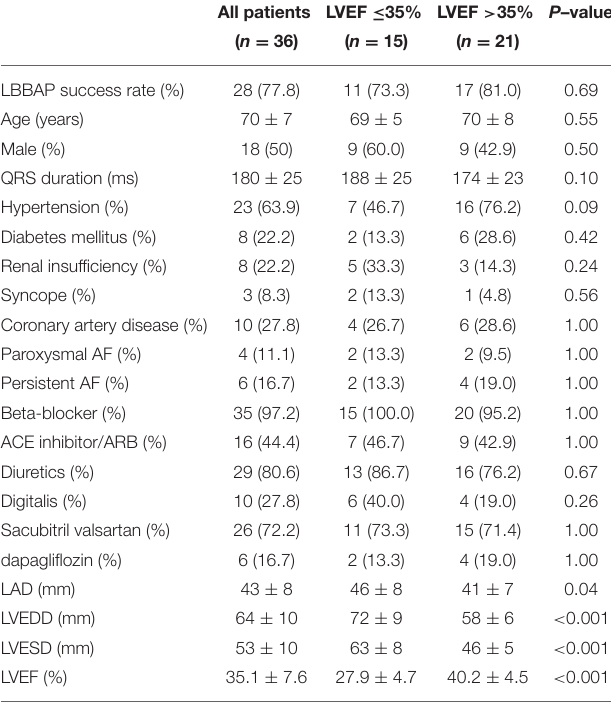
TABLE 1 | Baseline characteristics.